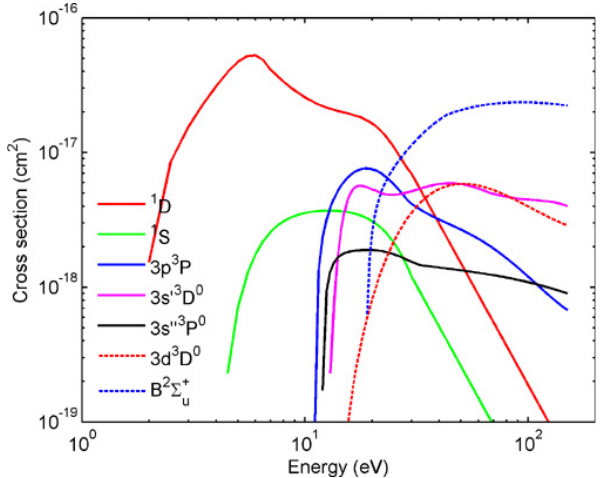
Fig. 1. Excitation cross-sections of optical emissions used in the